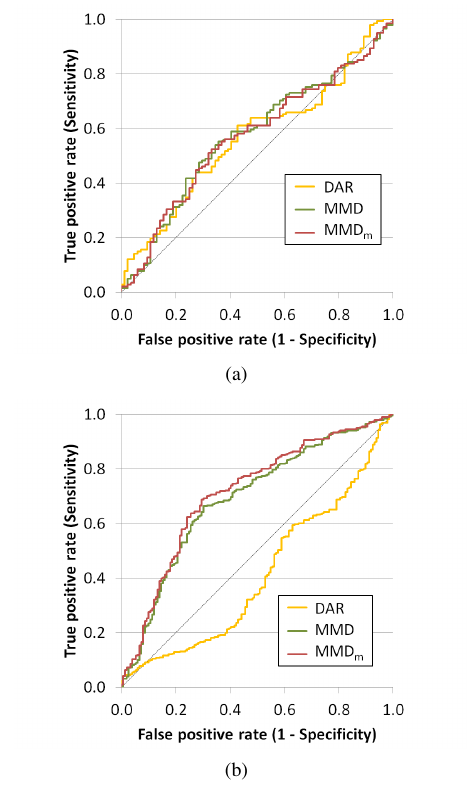
Figure 4: ROC curves for the prediction of negative transfer for Vaihingen (a) and Potsdam (b). DAR: Circular validation.